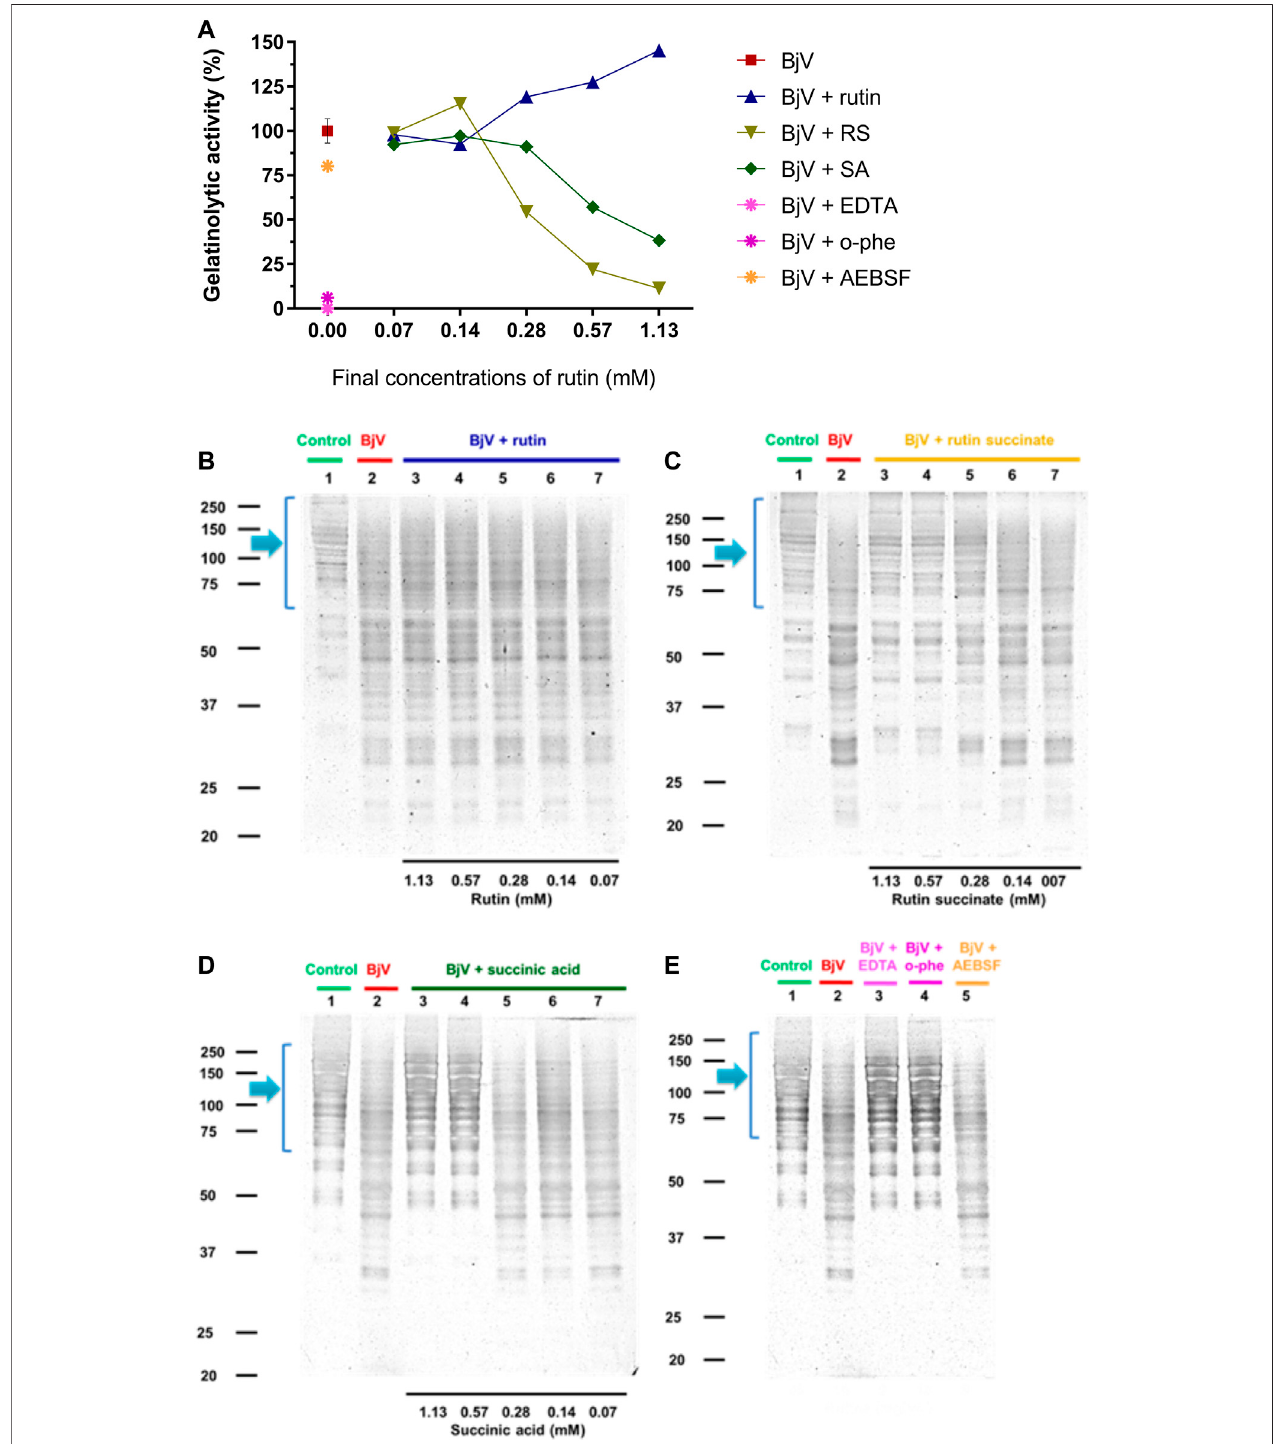
FIGURE 8 | (A – D) Activity of rutin, RS and SA at different concentration on BjV-induced gelatinolytic activity in vitro . (A) data were expressed as percentage of gelatinolyticactivity inducedbyBjValone; (B – E) gelatindegradation byBjVevaluatedbymeansofSDS-PAGEgels(10%).GelatinincubatedwithoutBjV(lanes1)orwith BjV solutions at 1.0 mg/ml (lanes 2); [ (B) , BjV + rutin], lanes 3 – 7, rutin concentrations ranging from 1.13 to 0.07 mM; [ (C) , BjV + RS], lanes 3 – 7, RS concentrations ranging from 1.13 to 0.07 mM; [ (D) , BjV + SA], lanes 3 – 7, SA concentrations ranging from 1.13 to 0.07 mM; (E) BjV + Na 2 EDTA (lane 3), BjV + o-phe (lane 4) and BjV + AEBSF (lane 5). Arrows refer to interest bands of 75 kDa – 250 kDa, relative to non-degraded gelatin.